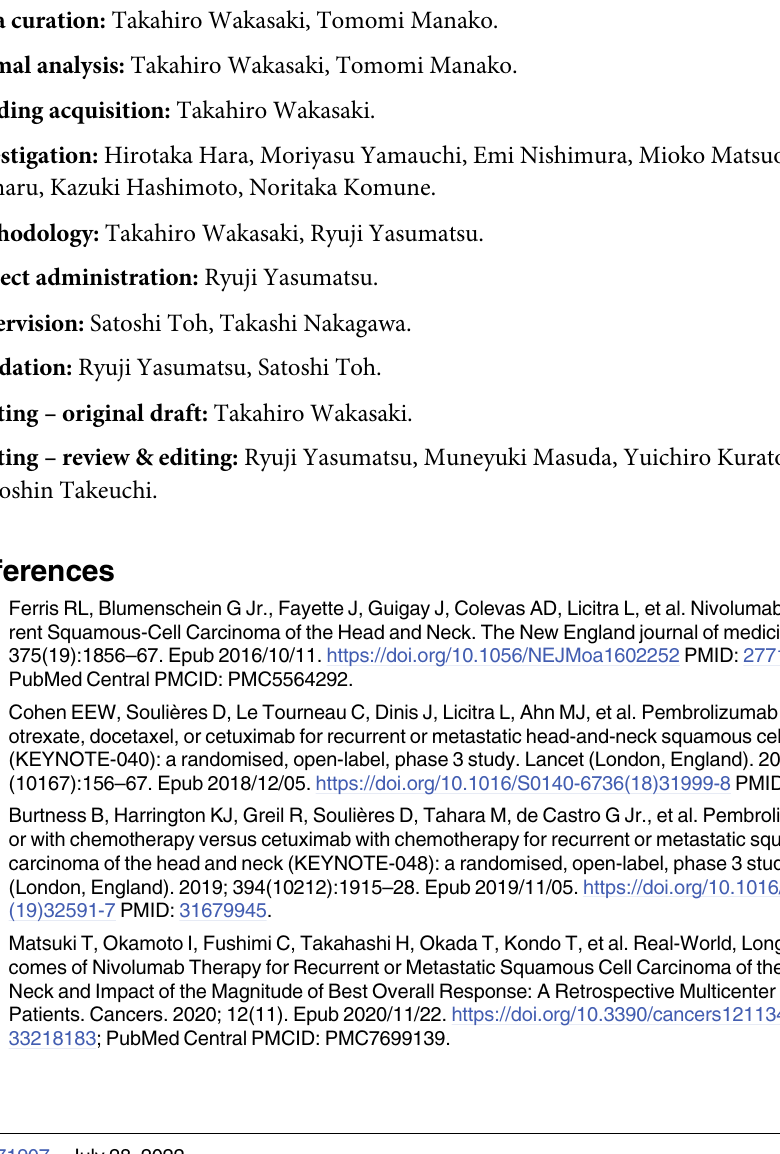
S2 Table. Profiles of AEs appeared during SCT in all patients. S3 Table. Characteristics of the patients in Groups A and